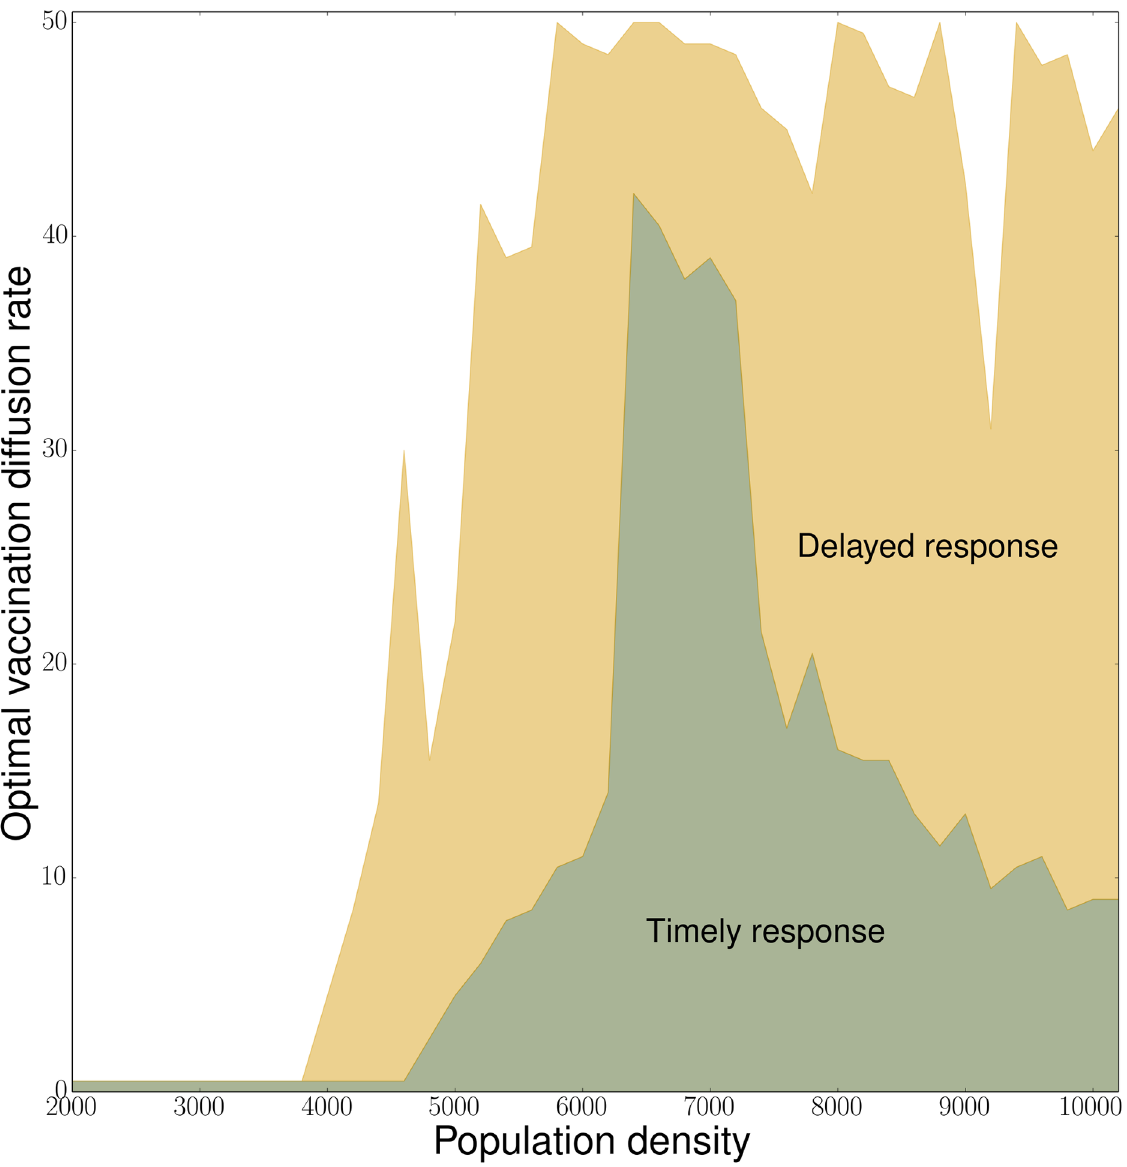
Fig 4. Optimal vaccination diffusion rates as a function of population density for a timely response (implemented at t = 0) and a delayed response of two epidemic generations (10 time steps later). Population densities are simulated from 2000 to 10201 at intervals of 200. Time step τ = 0.1, transmission rate δ = 2, recovery rate ρ = 0.2, vaccine intensity ε = 20, and interaction scale α = 1. The optimal diffusion rate indicates the minimum vaccination diffusion rate μ that minimizes the expected outbreak size for a given population density, computed from 60 simulation replicates for each value of μ